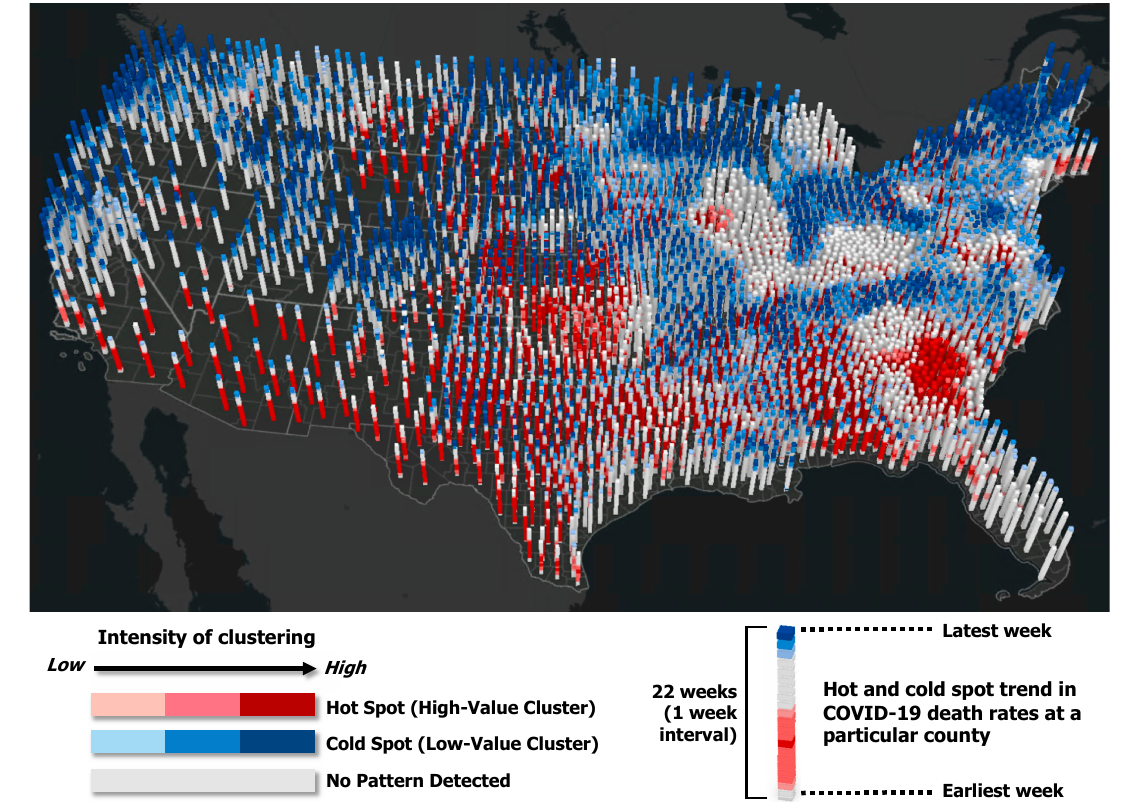
Figure 3. 3-D geovisualization of hot and cold spot trends of COVID-19 mortality rates in Period 3. Table 3. Parameter estimates of the global OLS